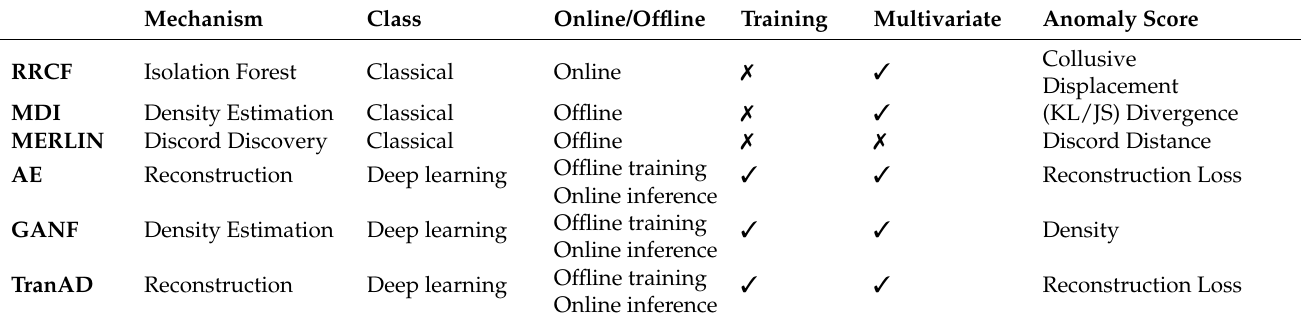
Table 1. Overview of the properties of the anomaly detection methods considered in this